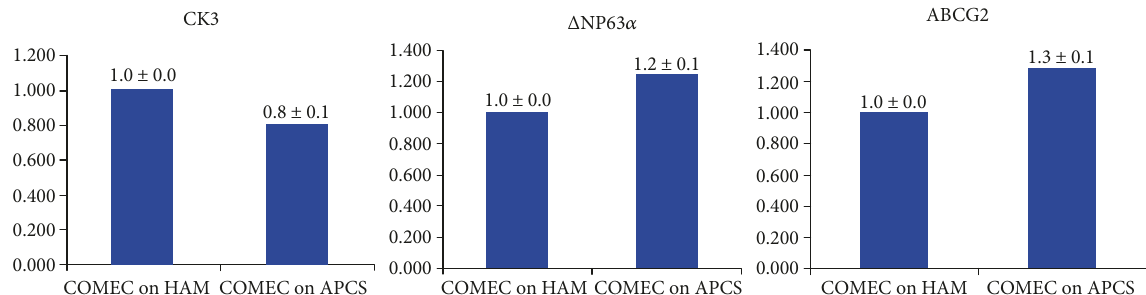
Figure 3: Quantitative real-time PCR analysis of comparison of putative epithelial cell marker expression. Bar chart showing the expression of CK3, Δ NP63 α , and ABCG2 in oral epithelial cells COME on HAM versus APCS ( P > 0 05 , n = 5